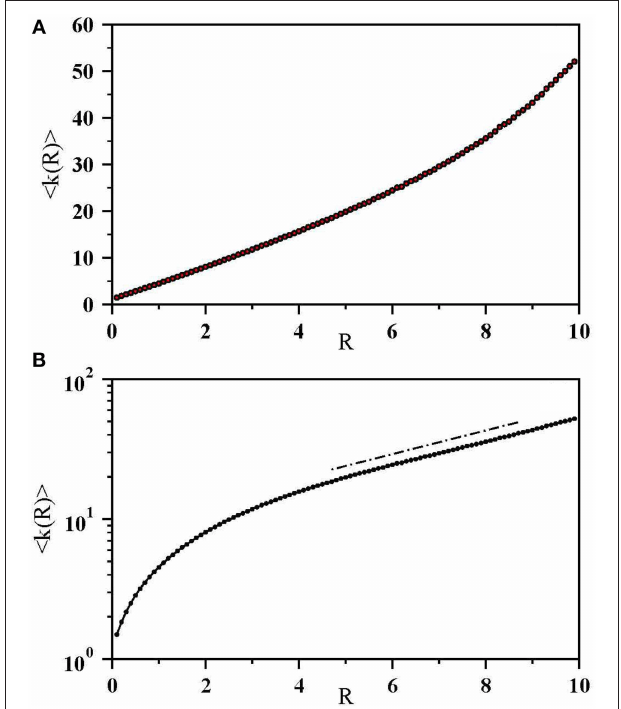
FIGURE 5 | (A) Average degree h k i as a function of disk radius, R for β = 1 . 0 . (B) The same plot in log-linear scale. The straight line is exp (0 . 2 R ) .